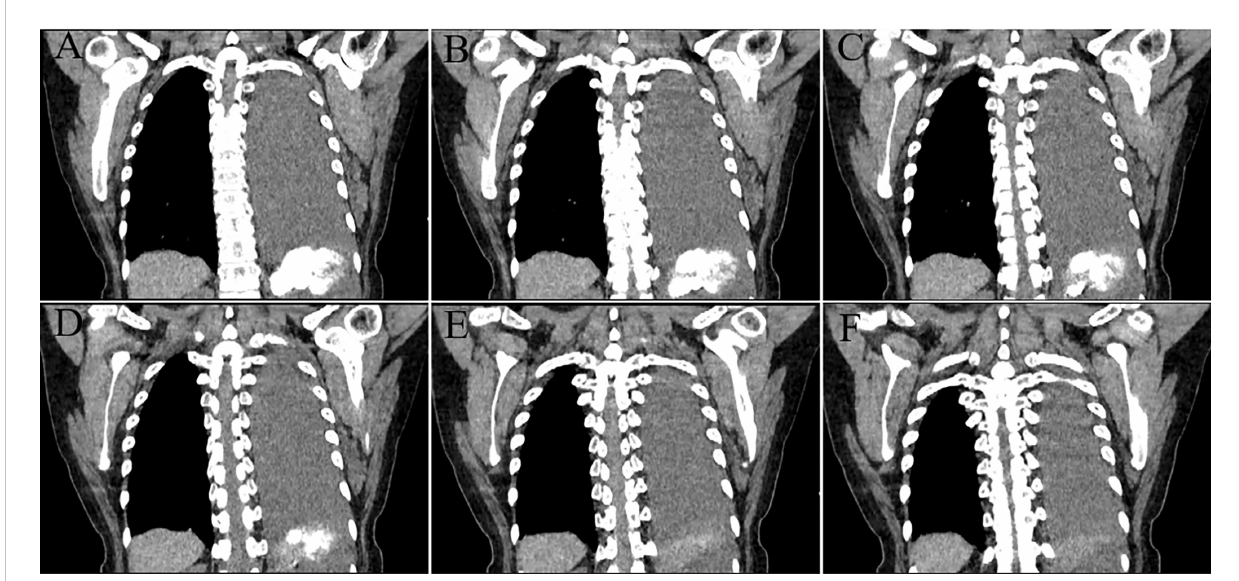
FIGURE 1 Continuous coronal computed tomography (CT) images. A mass with a high-density shadow was observed in the left thoracic cavity, with an irregular boundary and adjacent pleural thickening and adhesion. We intercepted a section of the continuous CT images from the appearance of the spinal canal to the disappearance of the tumor (A – F) , all of which showed no involvement of the spinal canal by the